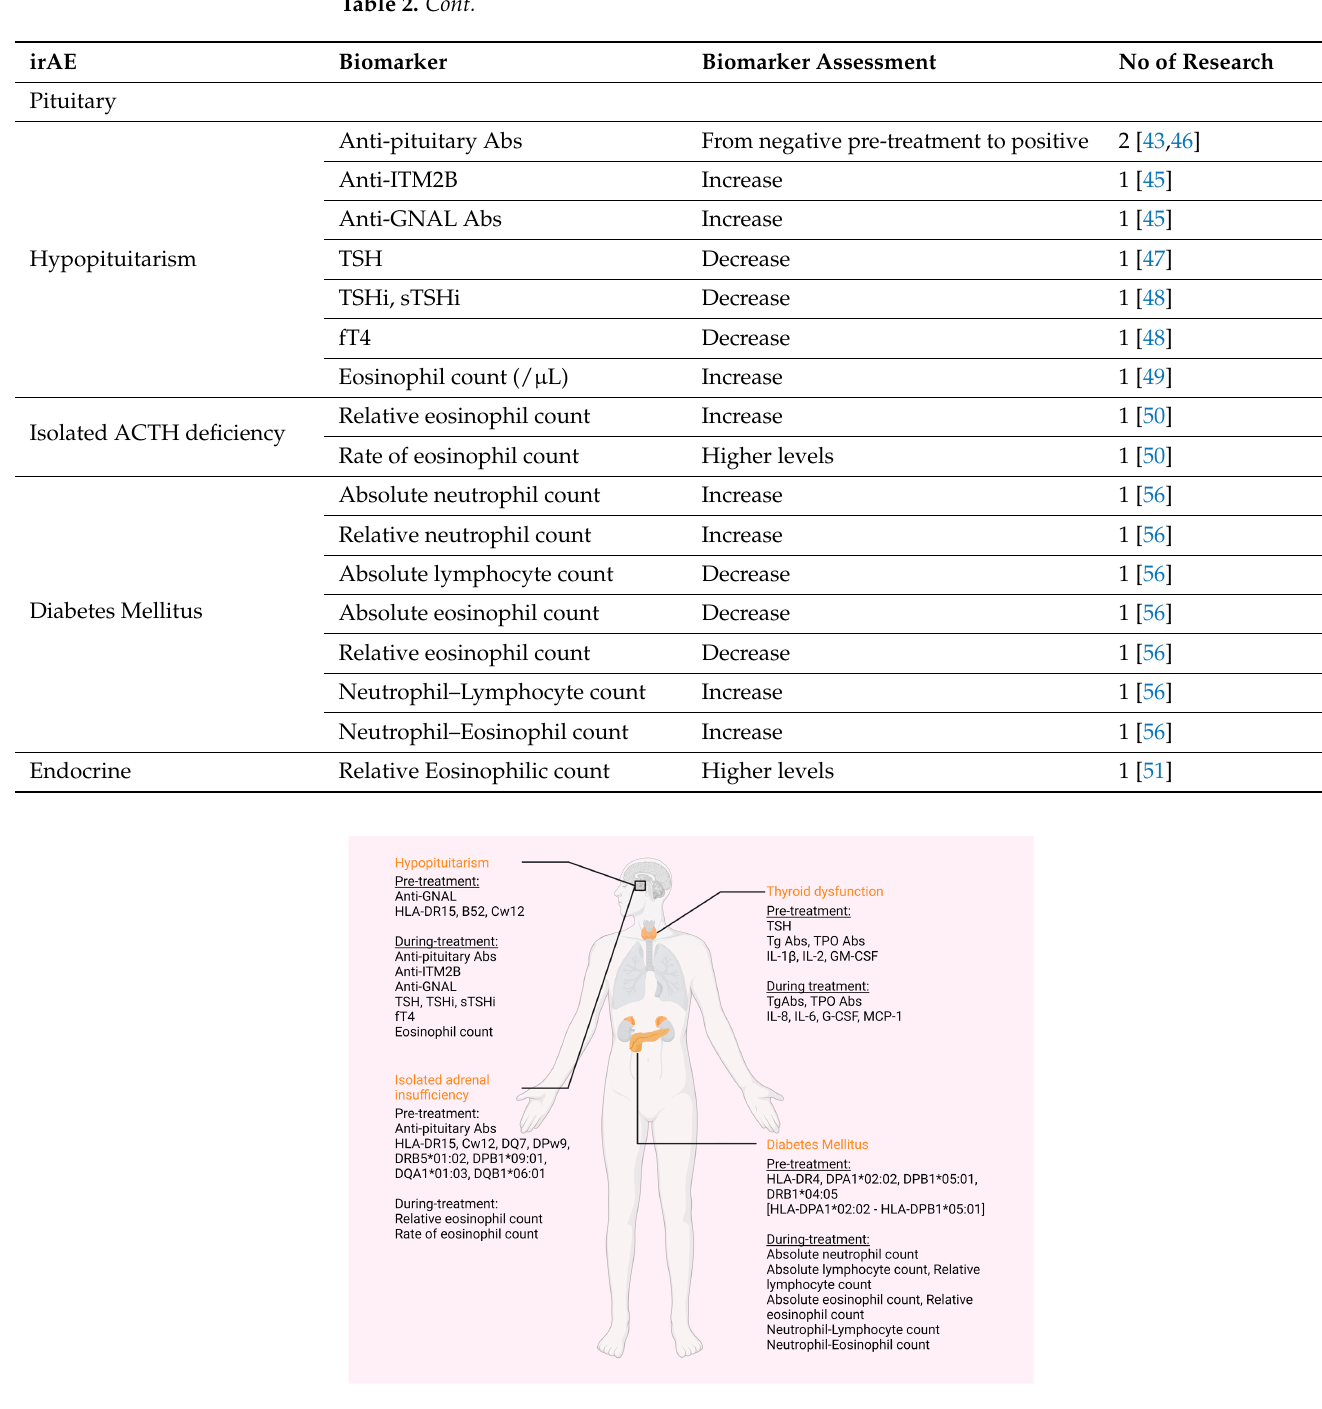
Figure 1. Immune-related adverse effects and corresponding possible biomarkers. Primary adrenal insufficiency and primary hypoparathyroidism have also been described following ICI treatment, but no biomarkers are available yet. HLA: human leukocyte antigen; Anti-GNAL abs: anti-guanine nucleotide-binding protein G(olf) subunit alpha antibodies; anti-ITM2B abs: anti-integral membrane protein 2B antibodies; TSH: stimulating thyroid hormone; TSHi: thyroid stimulating hormone index; sTSHi: standardized thyroid-stimulating hormone index; fT4: free T4; Tg Abs: thyroglobulin antibodies; TPO abs: thyroid peroxidase antibodies; IL: interleukin; G-CSF: granulocyte colony- stimulating factor; MCP-1: monocyte chemoattractant protein 1. (This figure was created based on the tools provided by Biorender.com, accessed on 7 November